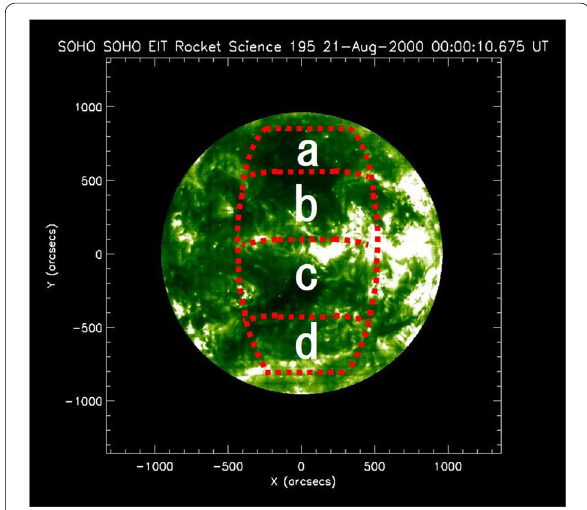
Fig. 2 The image of dividing four regions in Sun while surface